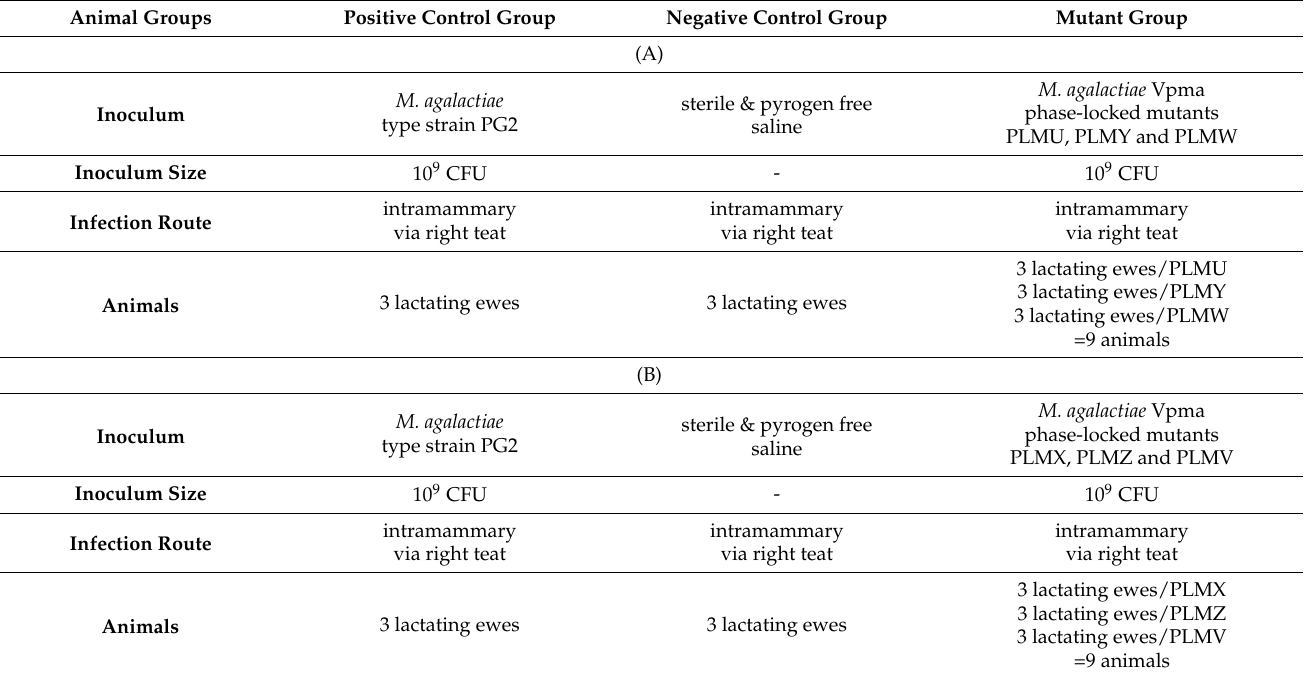
Table 1. Part 1 (A) and Part 2 (B) of experimental M. agalactiae infections of ewes carried out via the intramammary route.